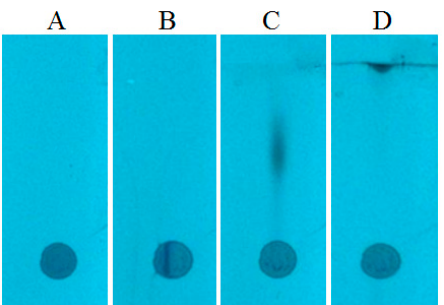
Figure 4. The mixture (serum sample) chromatograms: ( A ) after sample application; ( B ) after starting spot narrowing; ( C ) after first development; ( D ) after fourth development. Stationary phase: HPTLC Silica gel 60 F254. (Merck), mobile phase: methanol.